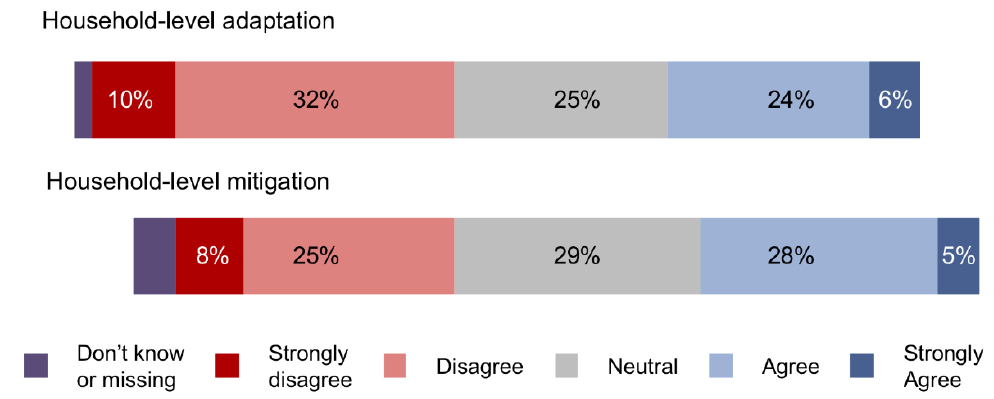
Figure 2. Overall distribution of responses to household-level mitigation and adaptation action.